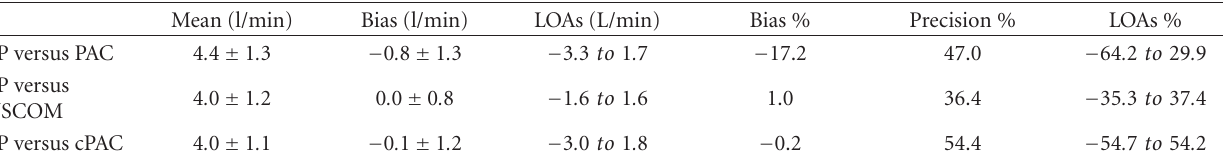
Table 1: Summary of comparison of methods for all paired measures and all sheep as absolute values and % values ( n = 280).